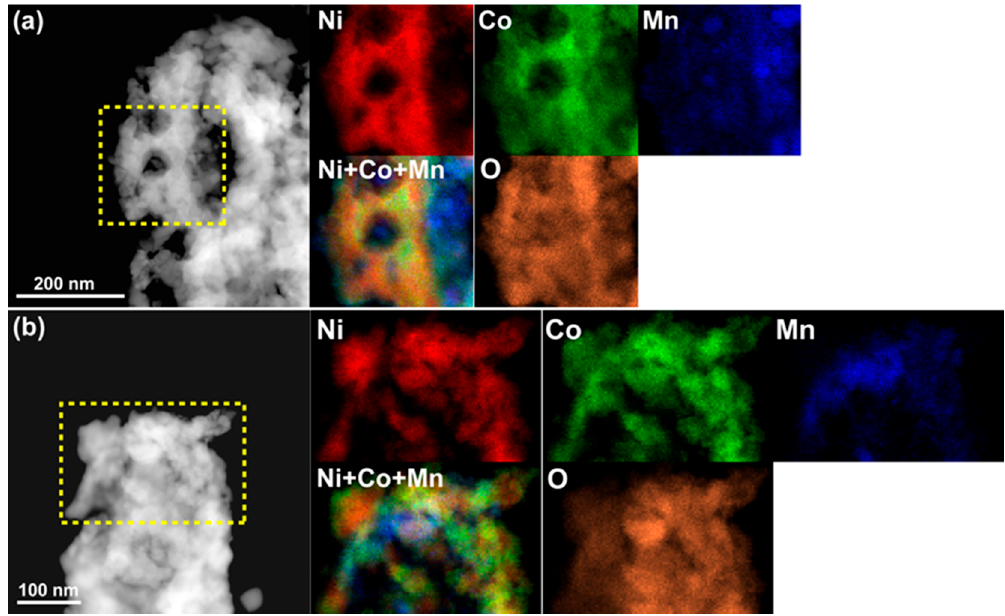
Figure 5. STEM images and EDS chemical maps of NP-NiCo after the in-situ TEM study. The selected areas in two different places ( a , b ) show the heterogeneous distributions of Ni (red), Co (green), Mn (blue), and O (orange) from Ni-K, Co-K, Mn-K, and O-K, respectively.